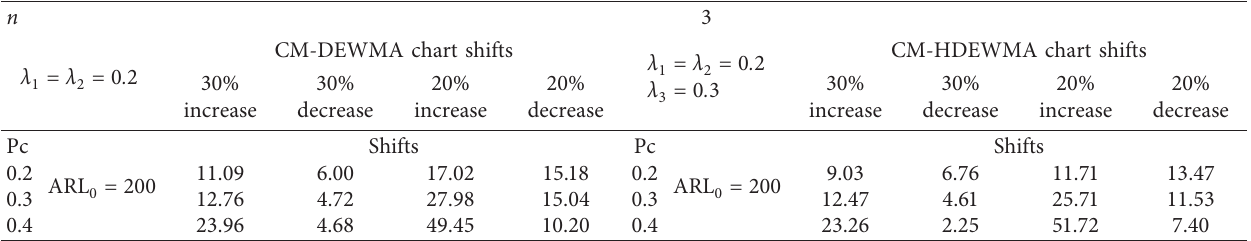
Table 5: Out-of-control ARL values for CM-HDEWMA and CM-DEWMA control charts for n � 7 with α � 1 , β � 0 . 75 . n 7 � λ � 0 . 2 λ 1 2